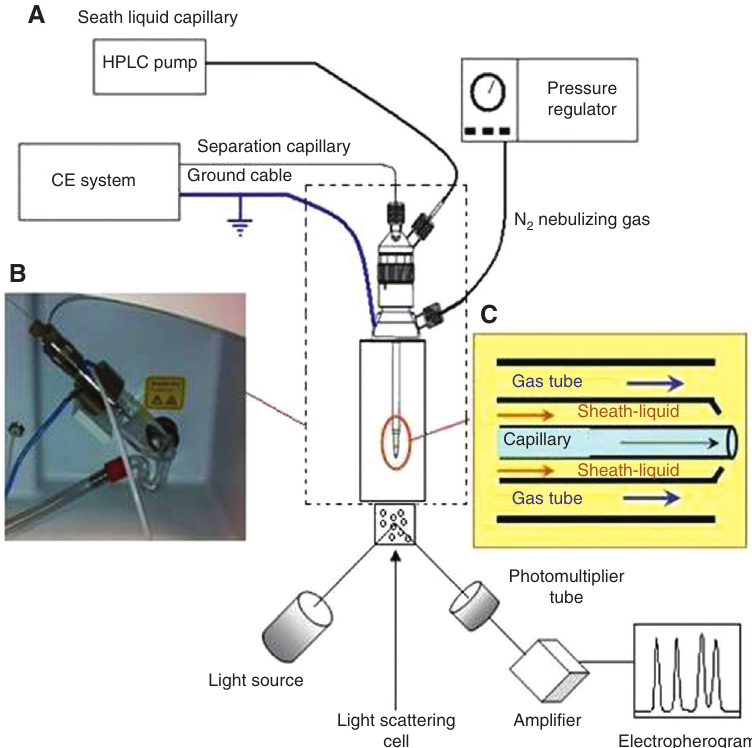
Figure 6 (A) Scheme of the interface for coupling the CE equipment with the ELSD detector via a stainless steel triple tube nebulizer; (B) picture of the nebulizer accommodated in customized nebulizer chamber and scheme of the different connections; and (C) details of the flow tubes to produce an efficient nebulization. Reprinted with permission from Bouri et al. 2013a,b. Copyright 2014 American Chemical